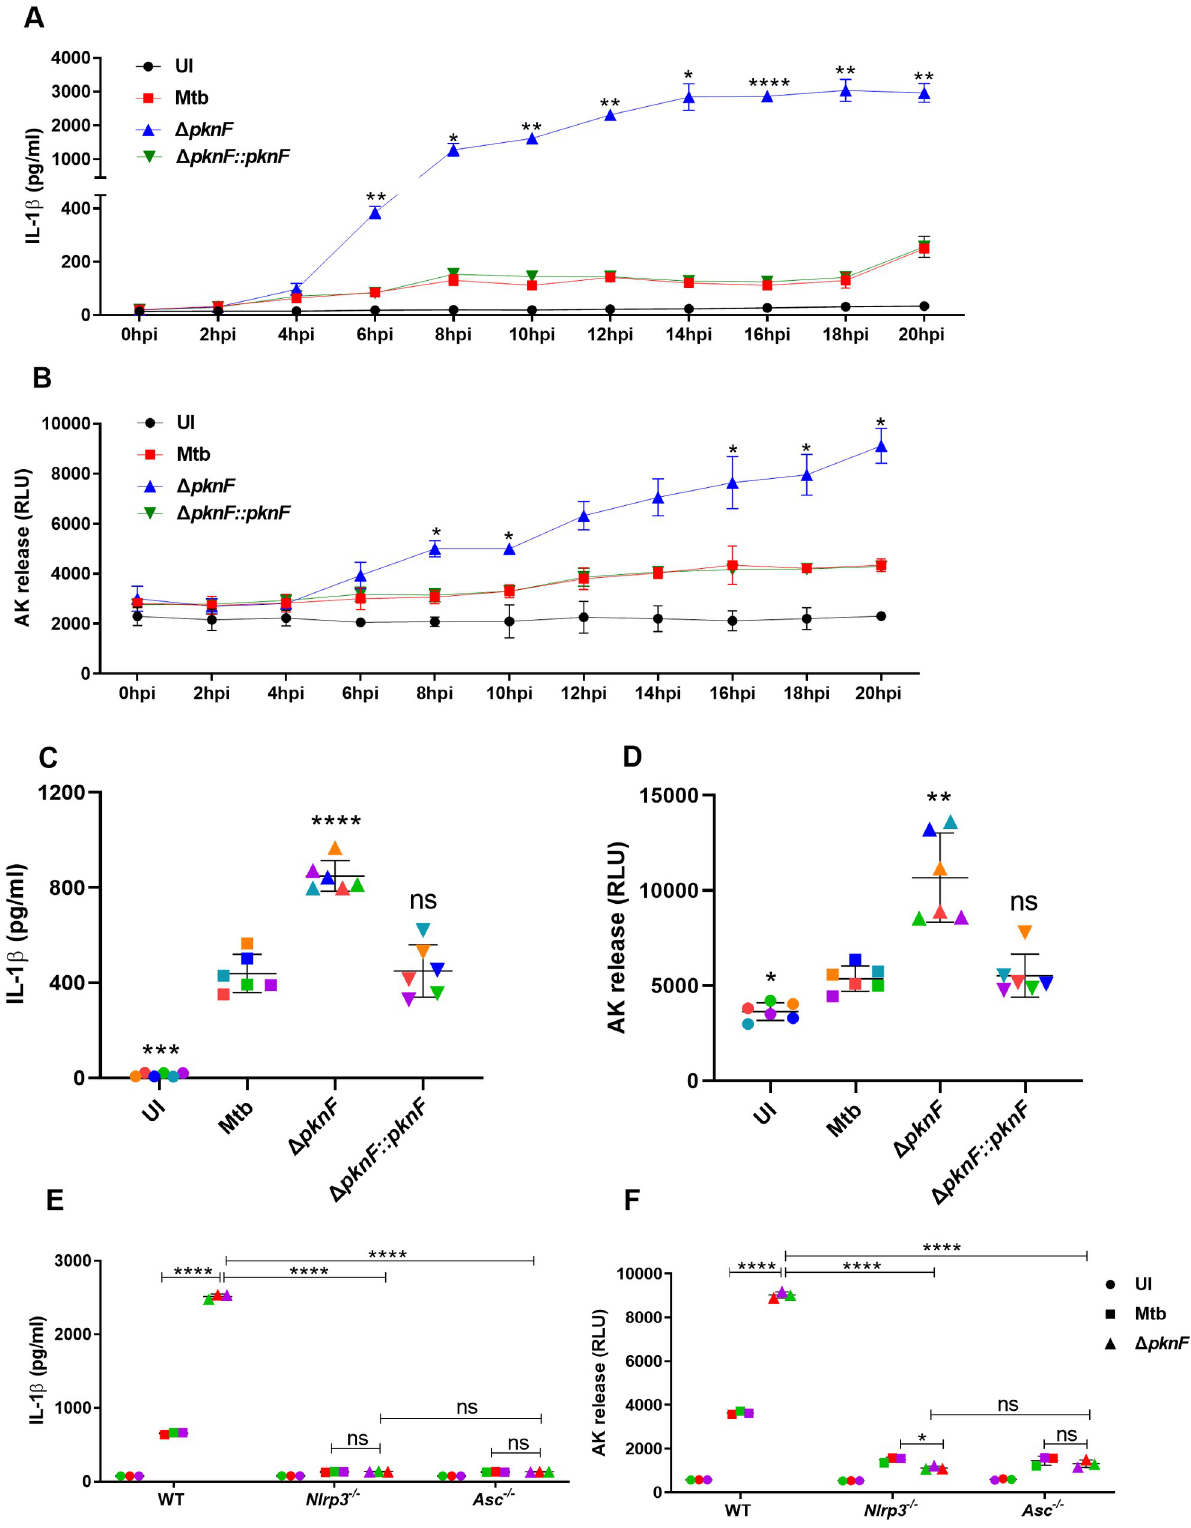
Fig 2. The deletion of pknF in Mtb leads to increased NLRP3 inflammasome and ASC dependent IL-1 β production and cell death in BMDM. BMDMs were either left uninfected (UI) or infected with different Mtb (CDC1551) strains (Mtb, Δ pknF mutant and complement Δ pknF :: pknF ) at